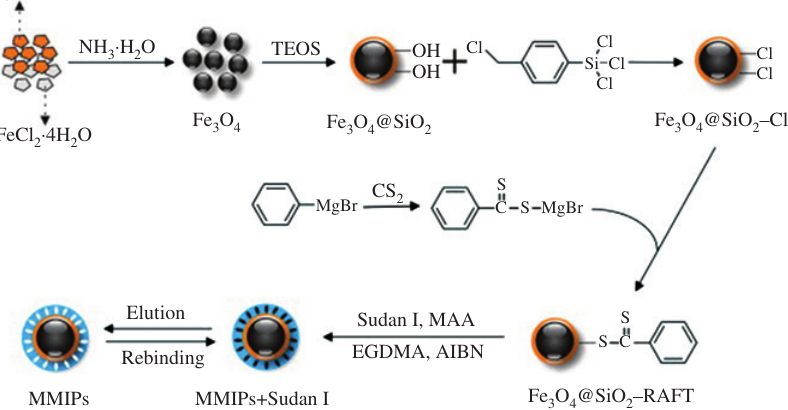
Figure 3: The synthetic strategy for MIPs based on magnetic particles. This figure was reprinted from Xie et al. (2015) with permission from